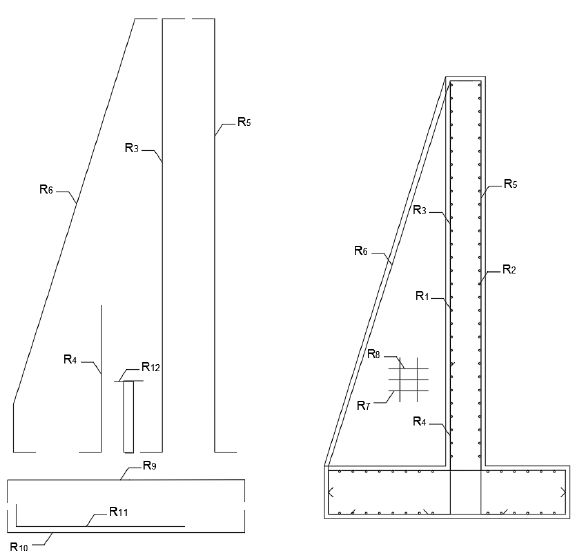
Figure 3. Reinforcement variables of the buttressed wall.